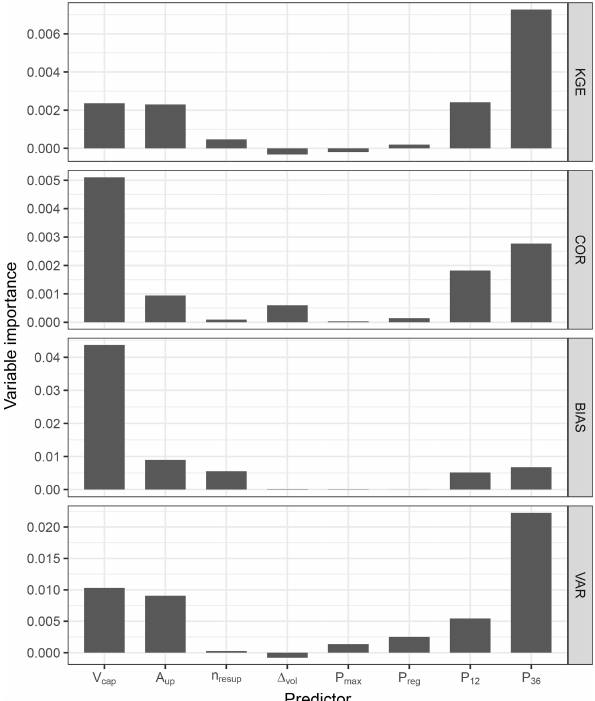
Figure 8. Predictor importances for each response variable deter- mined by the random forest approach. In this case conditional per- mutation importance was used (see Sect.